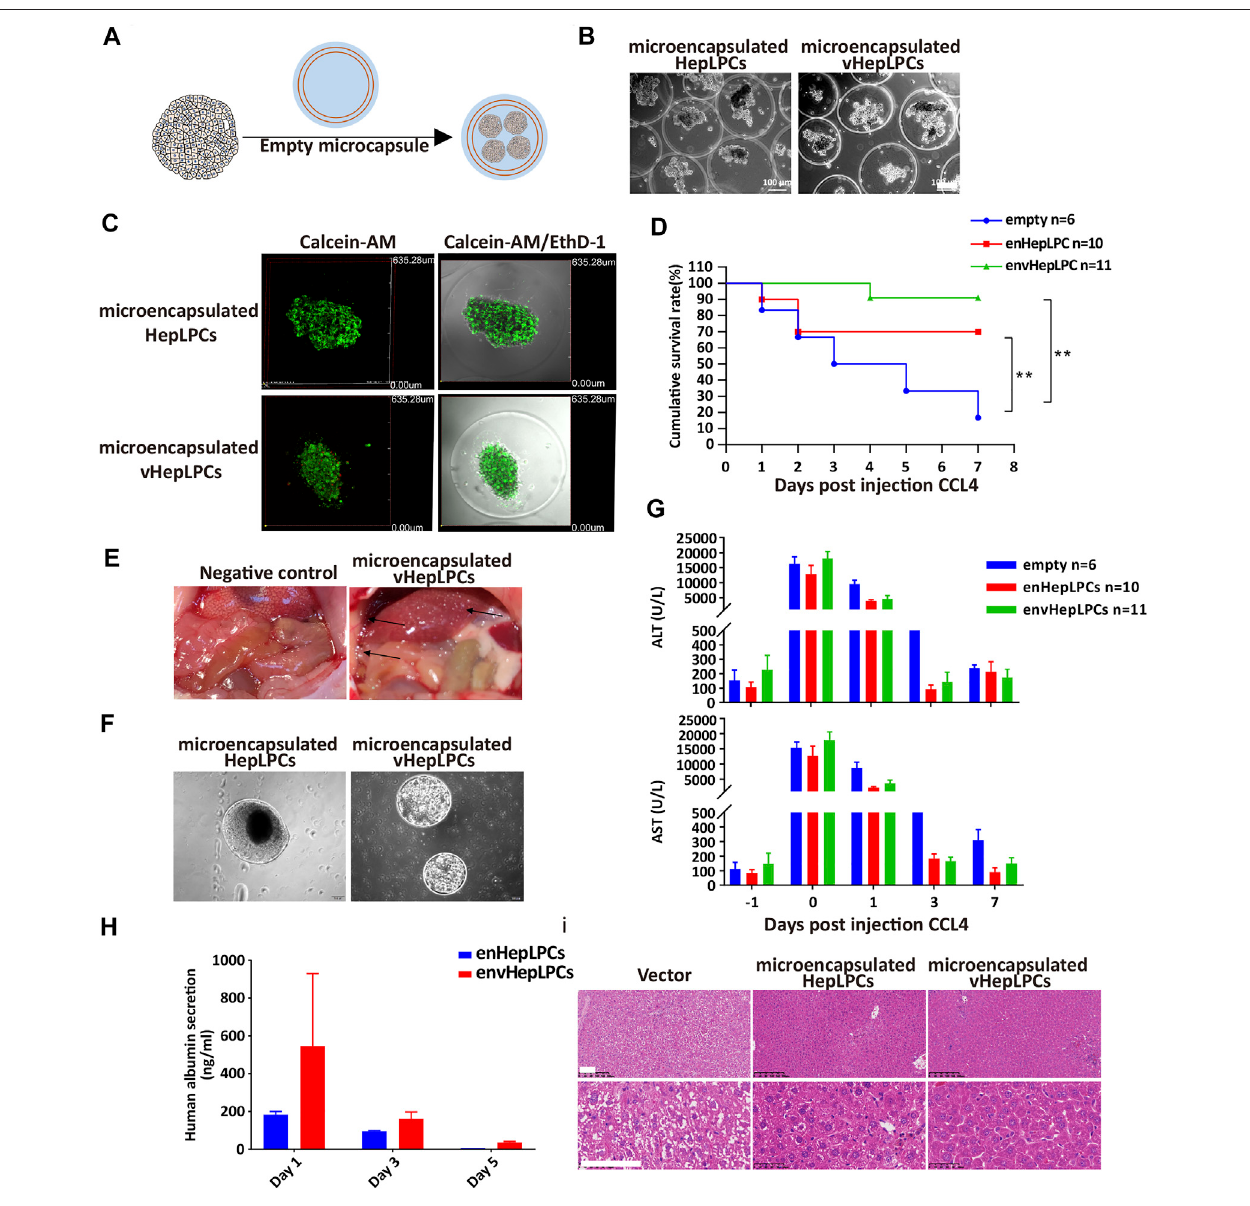
FIGURE 3 | Alginate microencapsulated vHepLPC spheroids signi fi cantly improved the survival rate of mice with liver injury. (A) Alginate microcapsule coating protocol diagram. (B) Bright- fi eld image of coated spheroids. (C) Cell viability test after microencapsulation. (D) Survival curve for acute liver injury mice with microencapsulated HepLPC spheroids ( n (cid:2) 10), vHepLPC spheroids ( n (cid:2) 11), or empty ( n (cid:2) 6) transplantation. (E) The microcapsule particles were enriched around the liver after transplantation. (F) Microcapsules recovered from the mouse abdominal cavity. (G) Serum levels of ALT and AST in CCL4-treated mice before and after transplantation (days one through seven) of microencapsulated spheroids. (H) Serum levels of human albumin secretion in CCL4-treated mice. (I) H&E staining 7 days after transplantation of alginate microencapsulated spheroids. The liver tissue after transplantation was signi fi cantly closer to normal tissue morphology. Data are presented as means ± SEM. ** p < 0.01. Scale bars, 100